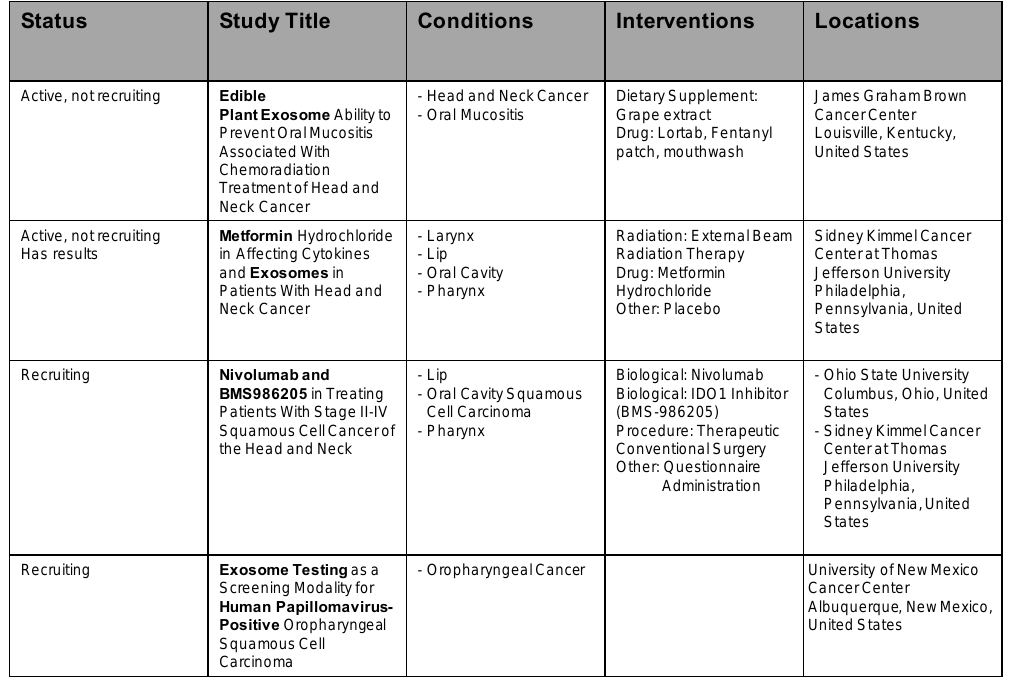
Figure 3. Ongoing clinical trials in cancer involving exosomes in HNSCC.